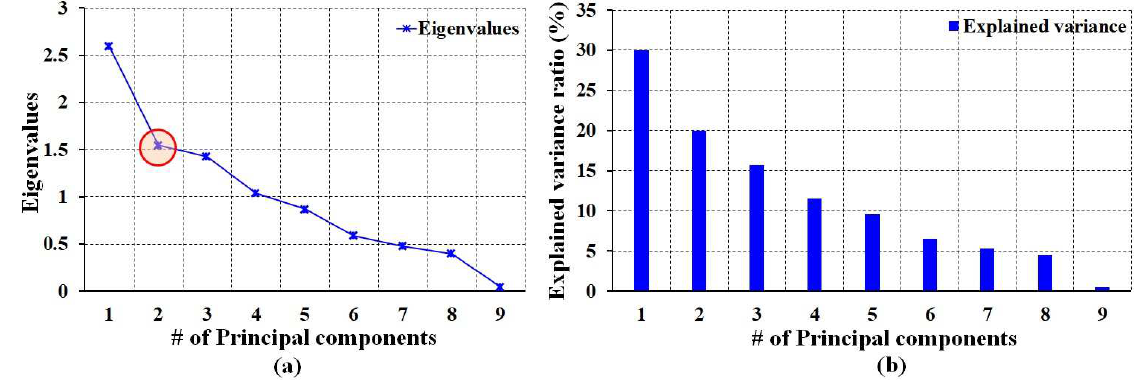
Figure 6. Principal component selection: ( a ) Scree plot; ( b ) Explained variance ratio